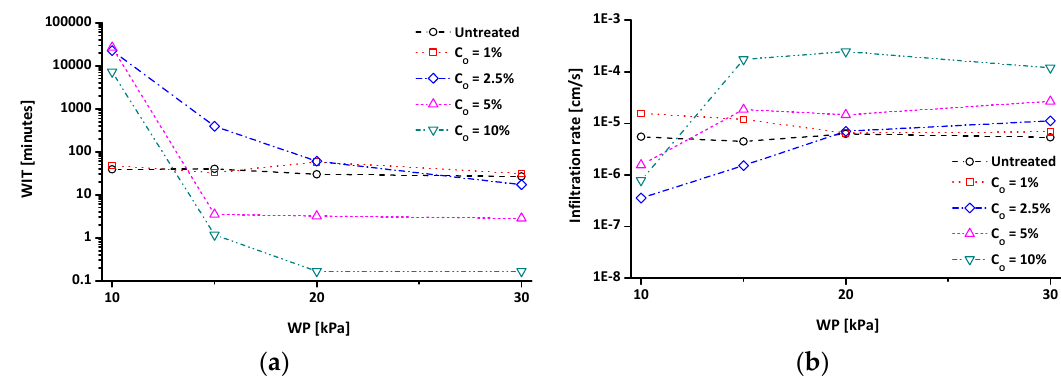
Figure 6. Effects of organosilane treatment concentration (C O ) and applied hydrostatic water pressure (WP) on ( a ) the water-infiltration time (WIT); and ( b ) the infiltration rate during WIT